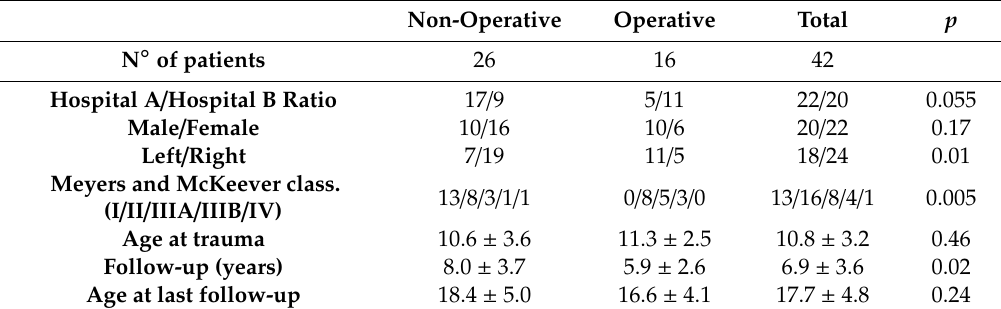
Table 2. Patients characteristics and baseline